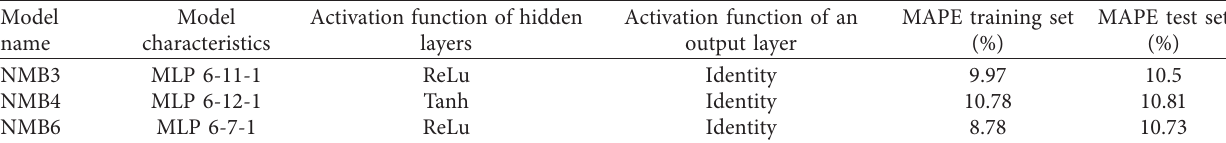
Table 7: Artificial neural network models for estimating concrete consumption (min-max normalization). Model